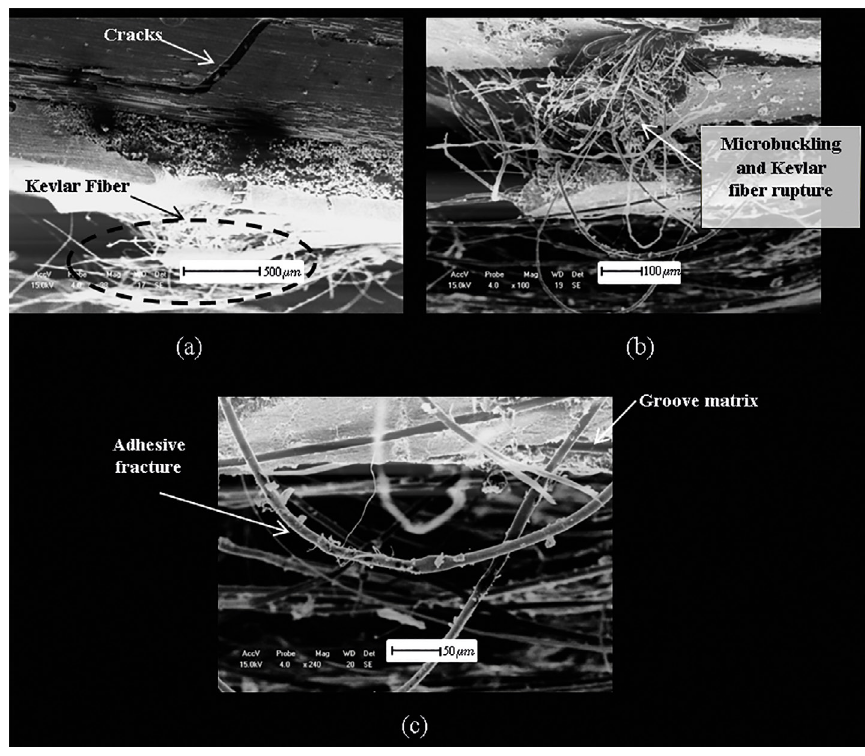
Figure 20. Fracture characteristics – HFCL laminate.